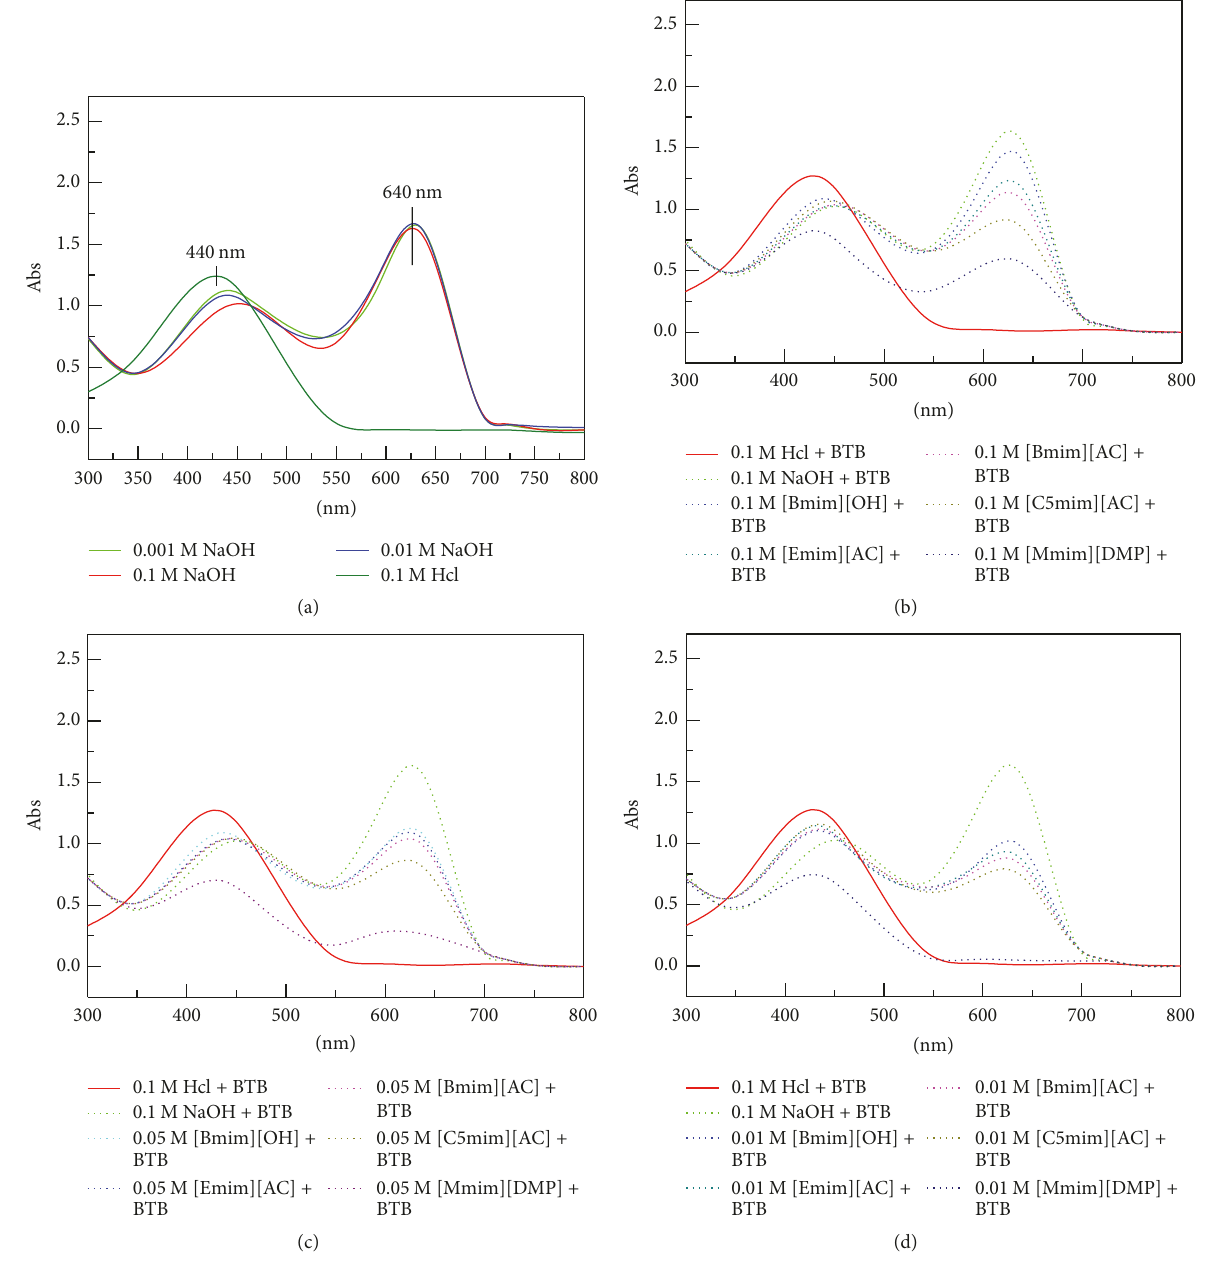
Figure 3: UV-Vis absorption of BTB in alkaline and acidic solutions and in different concentrations of alkaline ionic liquids. ((a) BTB in alkaline and acidic solutions; (b) BTB in 0.1 M ionic liquid; (c) BTB in 0.05 M ionic liquid; (d) BTB in 0.01M ionic liquid.)